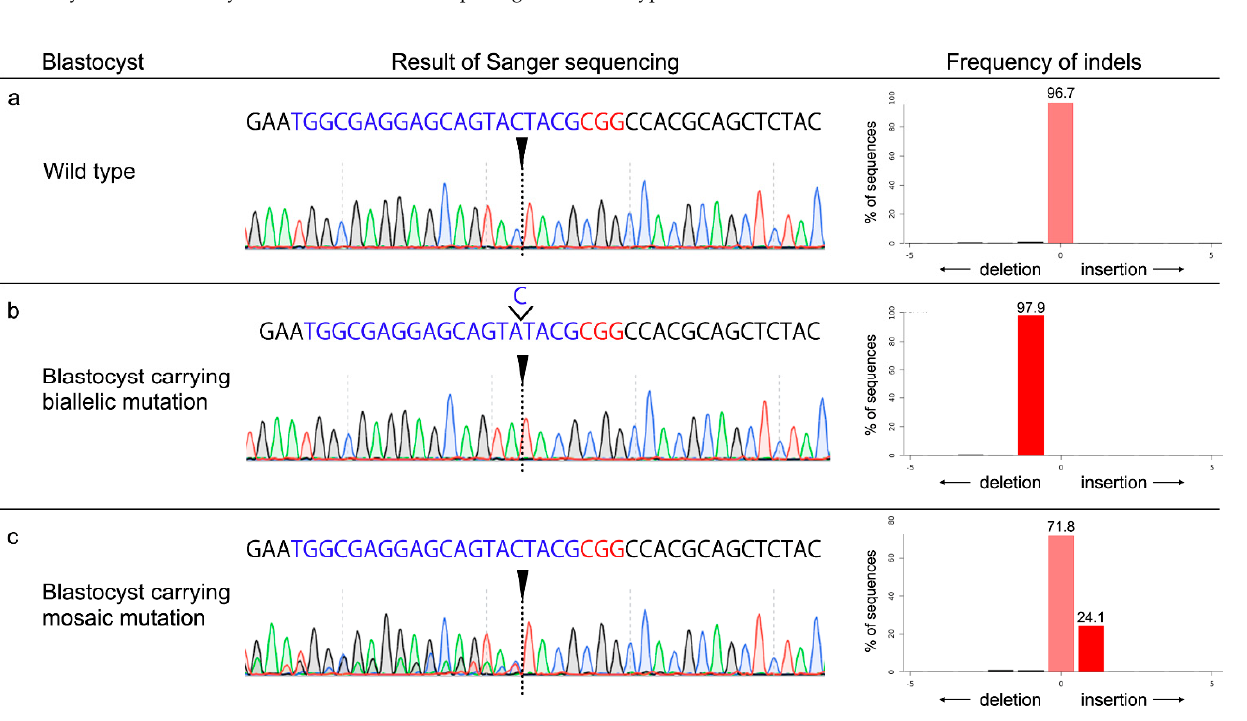
Figure 1. Representative results of the Sanger sequencing of blastocysts formed after lipofection-mediated gene editing with guide RNA (gRNA) targeting PDX1 and frequencies of indels decomposed from Sanger sequence data by tracking of indels by decomposition (TIDE) analysis. ( a ) Analysis of wild-type blastocyst. ( b ) Analysis of a blastocyst carrying biallelic mutation. The Sanger sequence trace consists of a 1-bp deleted sequence trace without the wild-type sequence. TIDE analysis compared the Sanger sequence data with wild-type sequence data and shows 1 bp deleted. ( c ) Analysis of blastocyst carrying mosaic mutation. The Sanger sequence traces of a blastocyst carrying mosaic mutation consist of composite sequence traces after the break site. TIDE analysis decomposed the Sanger sequence data, and wild-type and indel mutation with their frequencies are indicated. Arrowheads indicate the predicted Cas9 cleavage sites. Nucleotides in blue color indicate target sequences, nucleotides in red color indicate protospacer adjacent motif (PAM) sequences, and nucleotides in green indicate the deleted nucleotide. Table 1. Development of zona pellucida (ZP)-free embryos subjected to lipofection-mediated gene editing with gRNA targeting PDX1 or GGTA1 during in vitro fertilization (IVF) † .